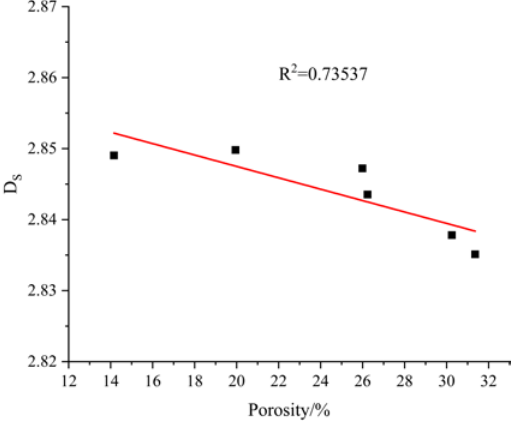
Figure 13. Relationship between fractal dimension and porosity.